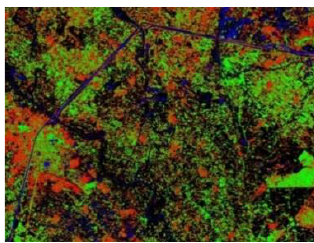
Fig. 9 Minimum distance classified PALSAR data